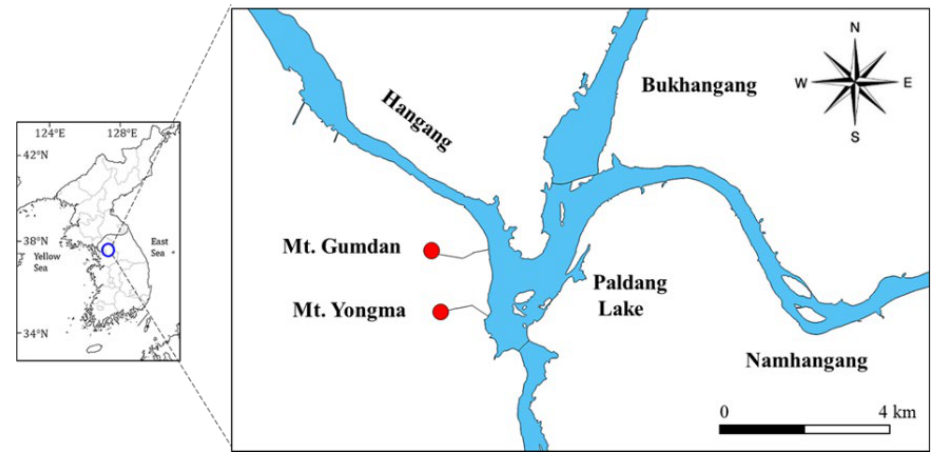
Figure 1. Map of sampling sites in mountain streams from Korea.